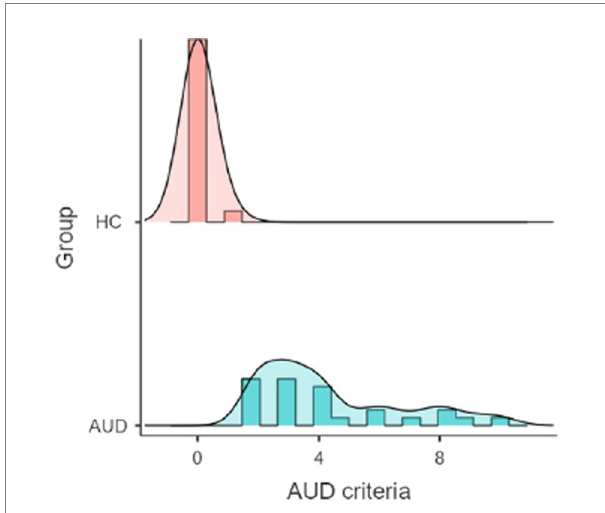
FIGURE 2 Density plot of the distribution of AUD criteria in the HC and AUD group.